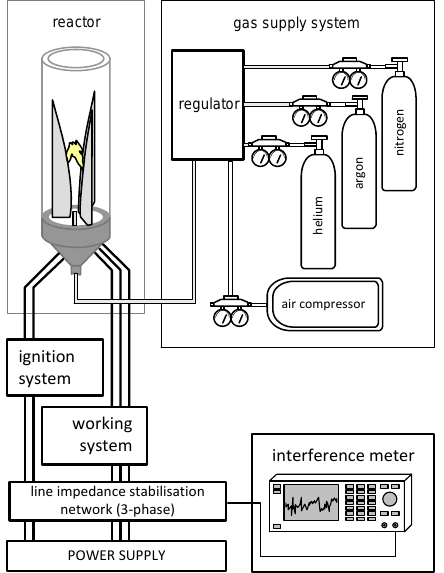
Figure 4. Measuring system for testing conducted emissions.